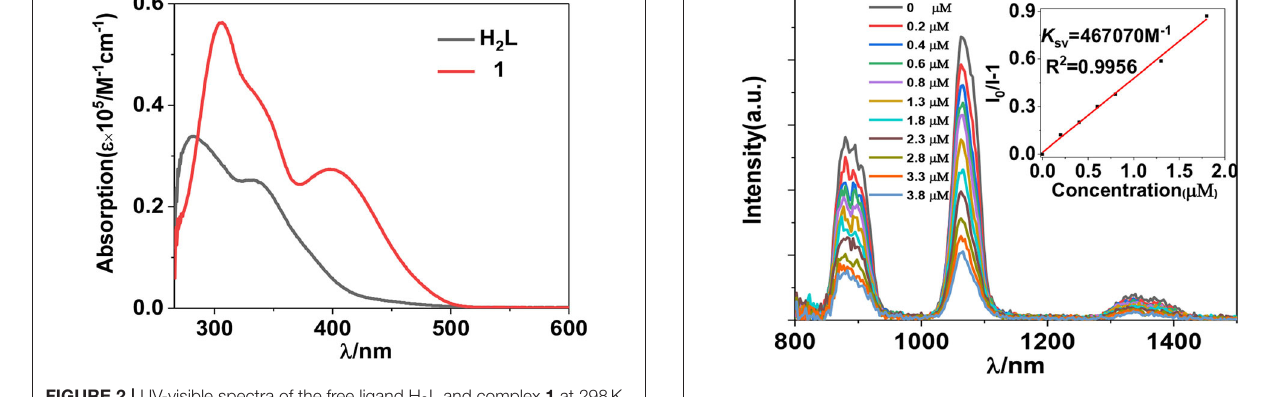
FIGURE 2 | UV-visible spectra of the free ligand H 2 L and complex 1 at 298K.